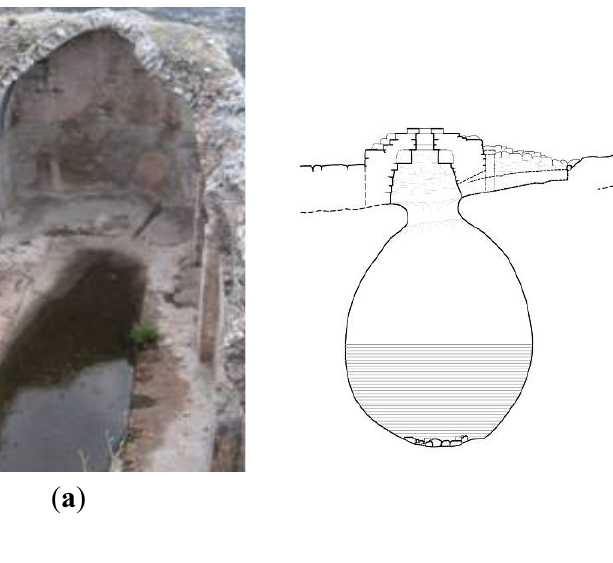
Figure 15. ( a ) The great cistern at the Goulas of the castle at Leontari Arkadias and ( b ) Combined cross-section of the single-vaulted cistern in Ag. Anna on Amorgos dated to the Byzantine times [35] and the pear-shaped newer one (with permission of G.P.